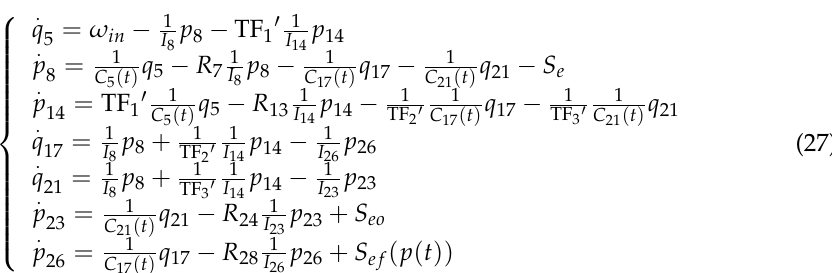
Table 3. Numerical simulation parameters.